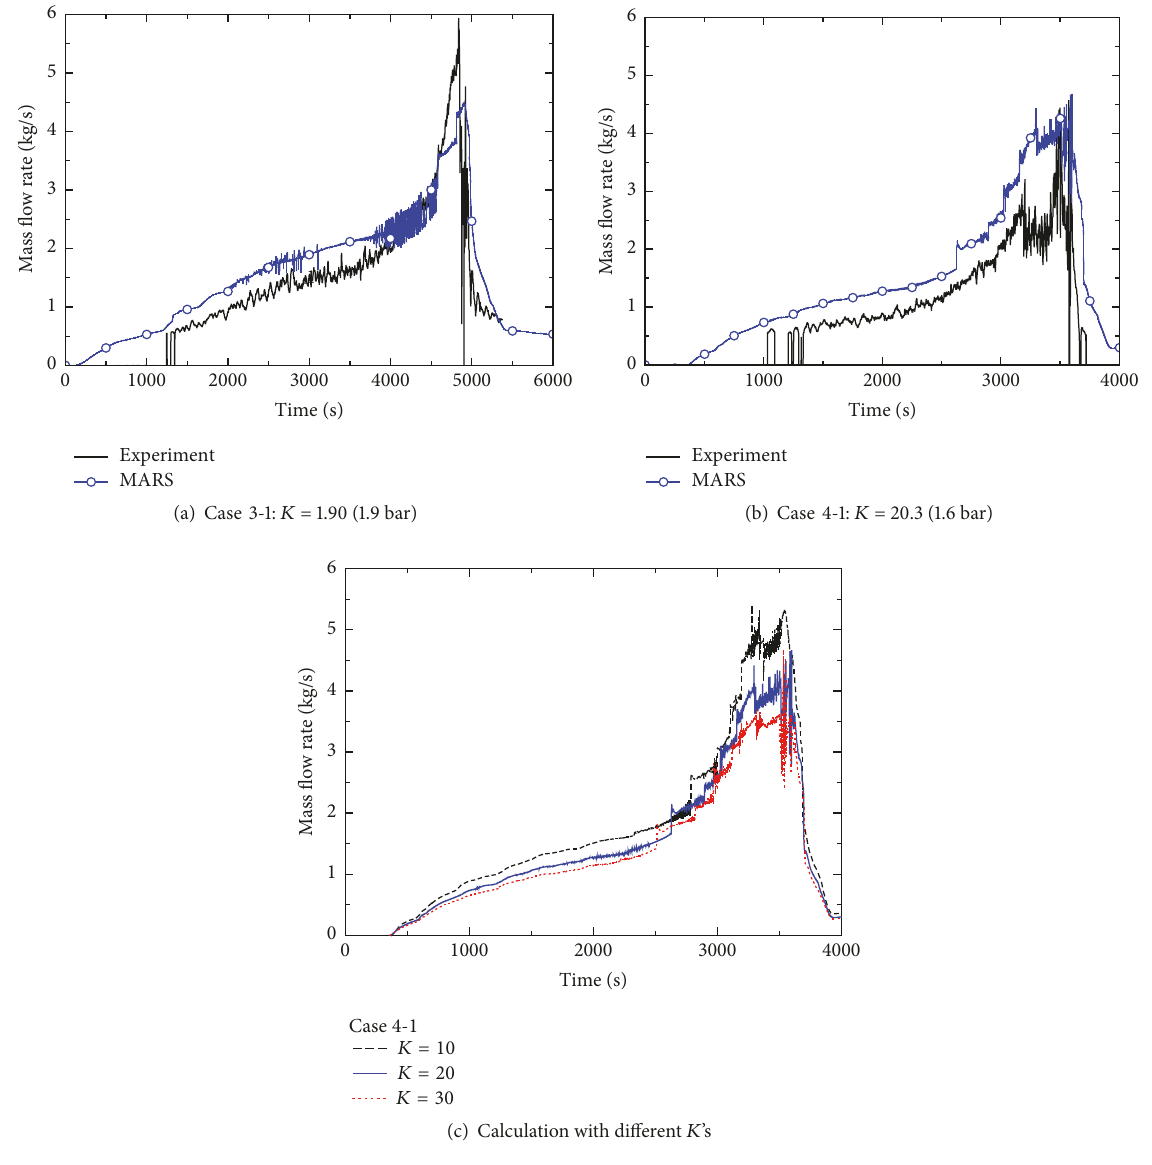
Figure 13: The effect of loss coefficient on the natural circulation flow